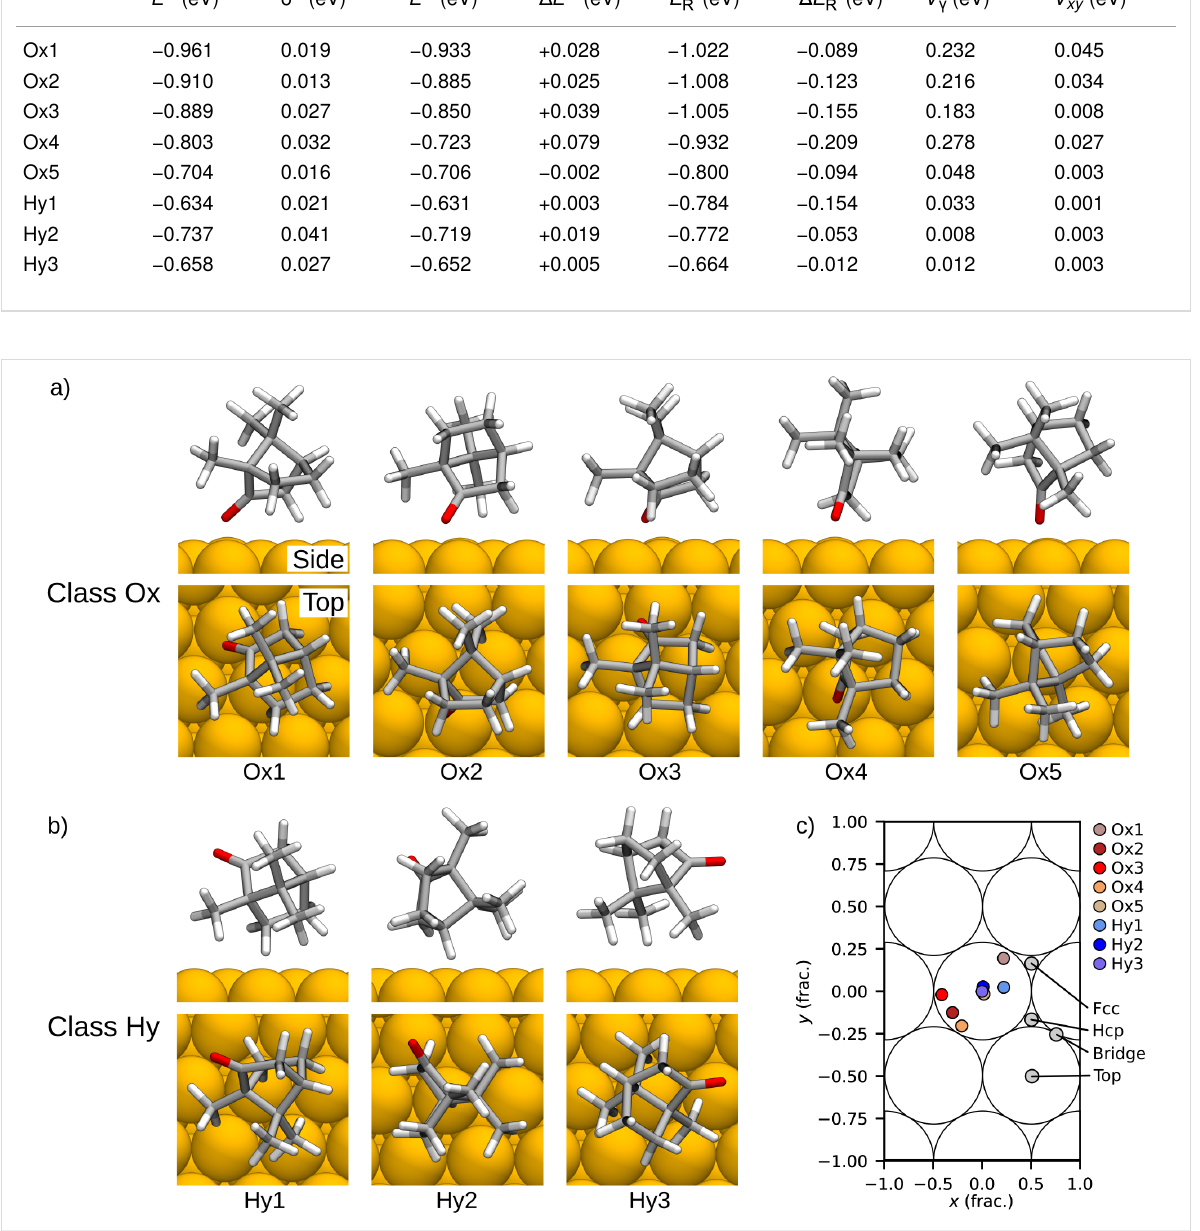
Figure 6: Relaxed stable adsorbate structures of camphor on Cu(111) in the 6D search, showing (a) chemisorption of the molecule via oxygen (class Ox) and (b) physisorption via hydrogen (class Hy). (c) Adsorption site of camphor in the relaxed structures (center of the molecule) and the high- symmetry points of the Cu(111)